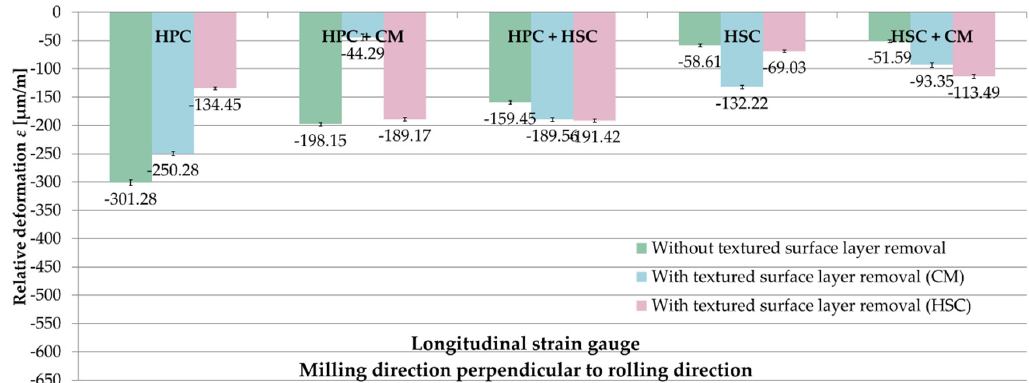
Figure 13. Comparison of the relative deformations ε from the longitudinal strain gauges depending on the applied pre-machining–milling direction parallel to rolling direction.